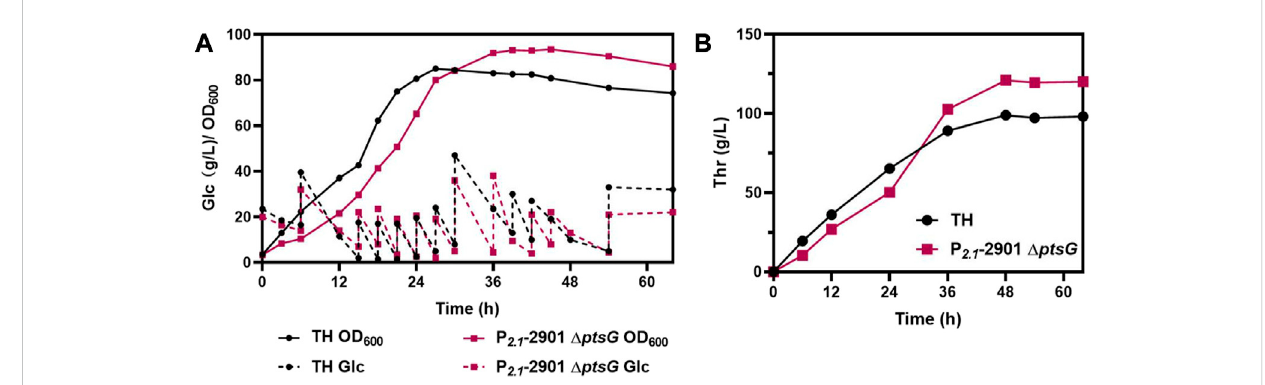
FIGURE 7 Thefed-batchprocesswithP 2.1 -2901 Δ ptsG andTHina5-Lbioreactor.Biomass,glucoseconsumption,andL-threoninetiterweremonitoredinreal time. (A) Biomass and glucose consumption of strains. (B) L-threonine titer of strains.